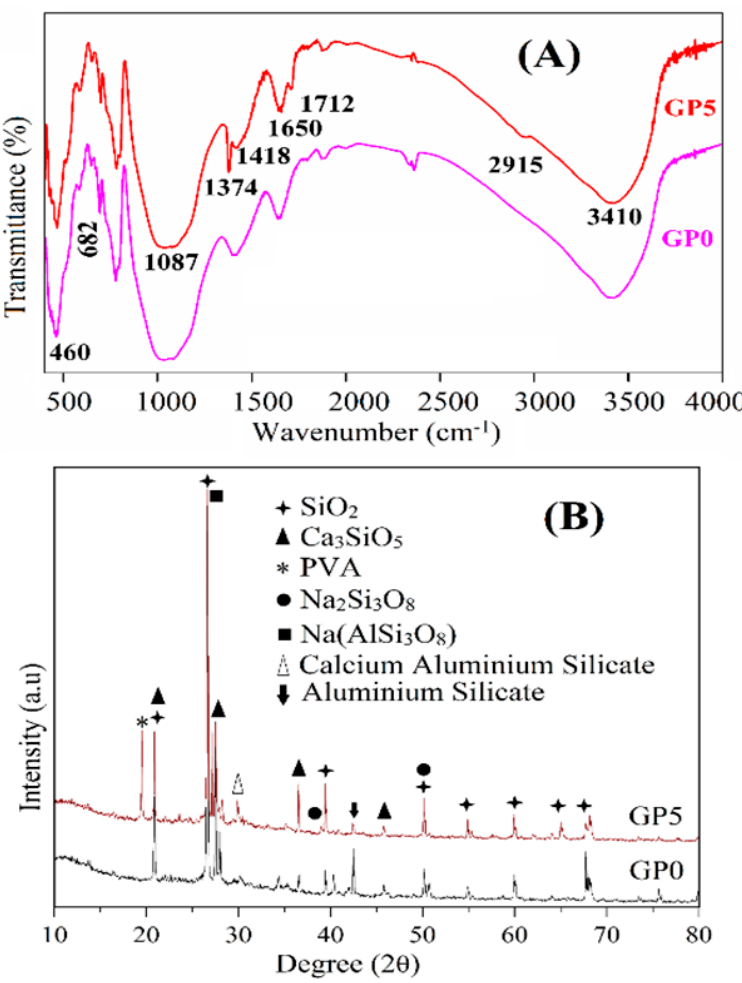
Figure 17. Microstructural study: ( A ) FTIR spectra; ( B ) XRD.